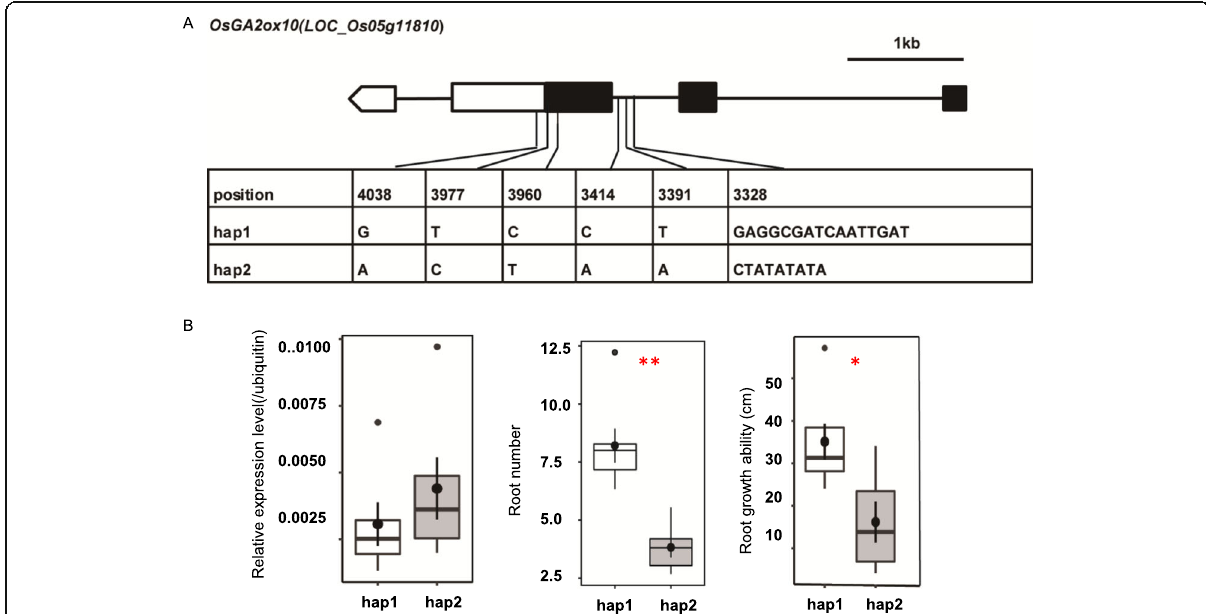
Fig. 7 Analysis of DNA polymorphisms in the OsGA2ox10 gene and comparison of relative expression level of it between groups with different haplotypes. a Gene structure of the candidate gene LOC_Os05g11810 ( OsGA2ox10 ); the solid box and empty box indicate the exon and untranslated region, respectively. b Boxplots of relative expression level, RN and RGA in different haplotypes of LOC_Os05g11810 ( OsGA2ox10